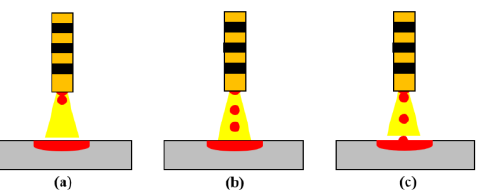
Figure 5. The schematic diagram of the globular transfer mode: ( a ) initial stage, ( b ) process stage, ( c )final stage.